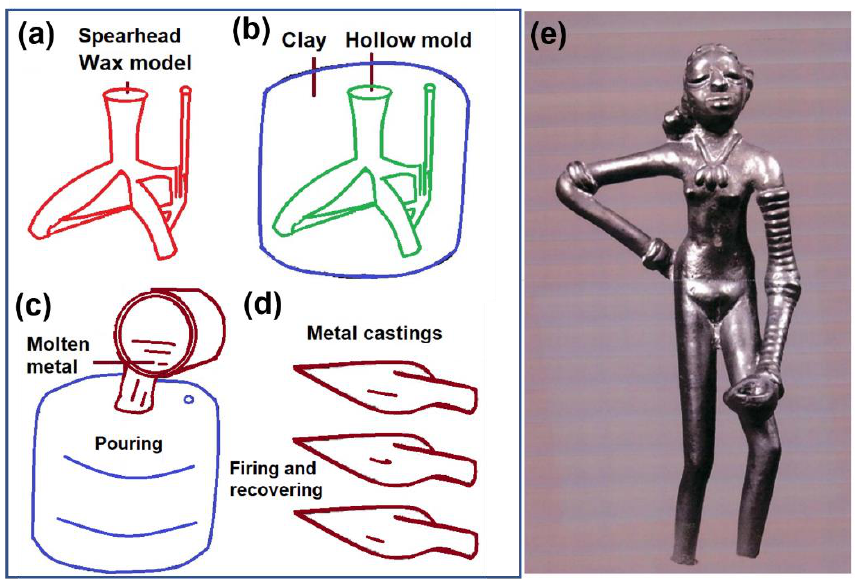
Figure 8. LWC of ancient spearheads. ( a ) Wax model assembly: ( b ) Placing of the wax model in the clay mold; ( c ) pouring of liquid metal into the clay mold after wax draining; and ( d ) detachment of the mold to obtain the solid product [109]. ( e ) Dancing girl sculpture.